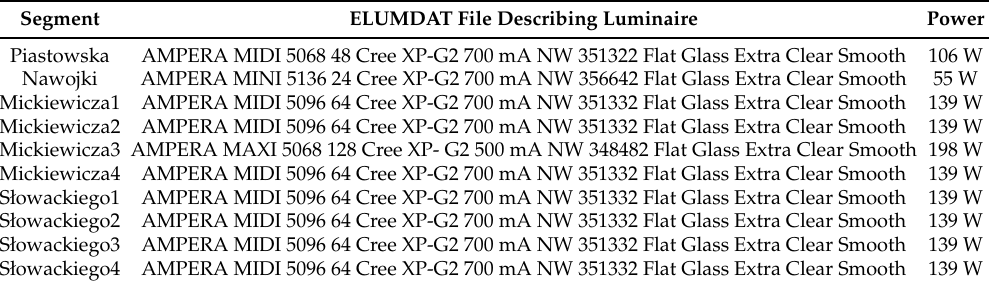
Table 2. List of luminaires installed on streets.